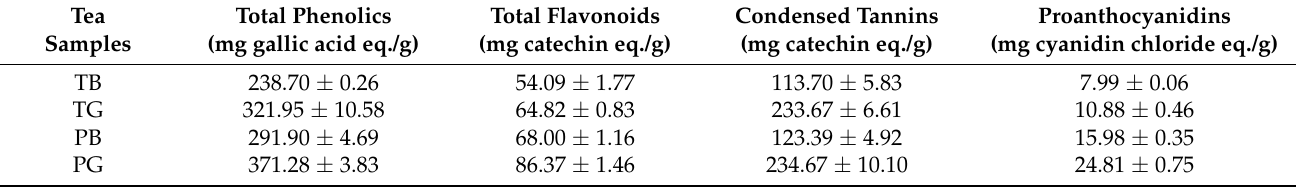
Table 1. The comparisons of total polyphenols, flavonoids, condensed tannins and proanthocyanidins between various tea